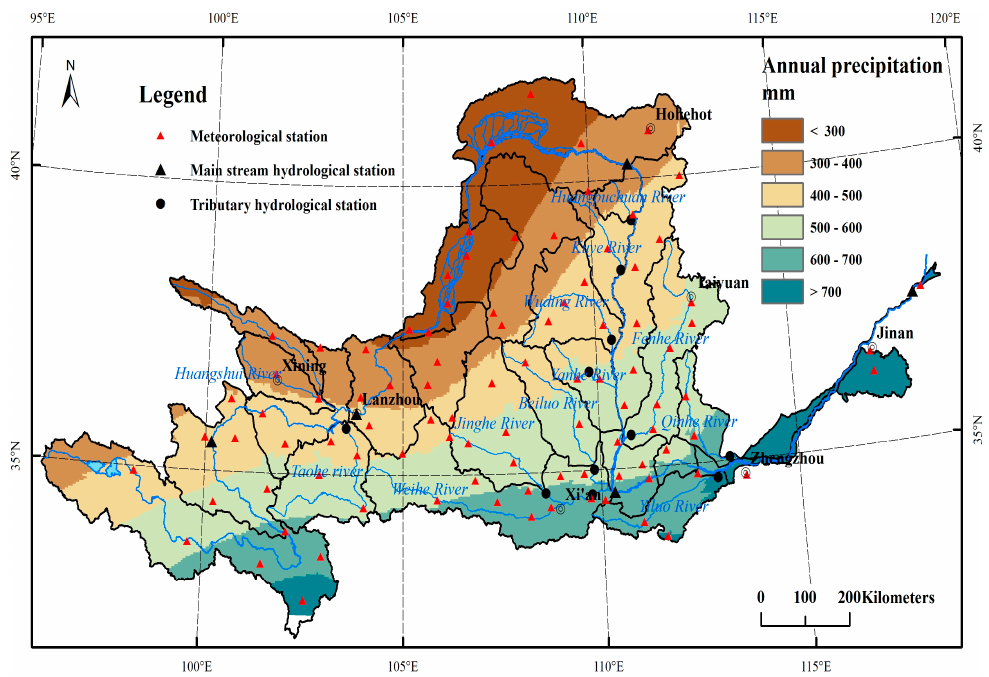
Figure 1. Annual precipitation and locations of hydrological and meteorological stations in the Yellow River basin.